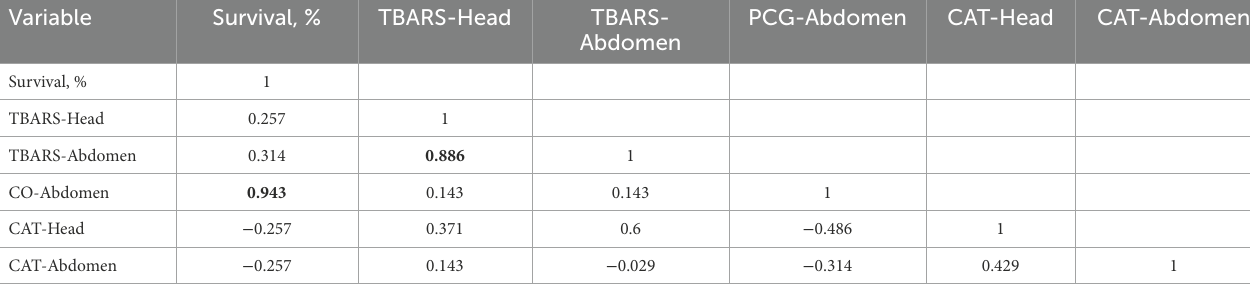
TABLE 1 Spearman rank order correlations among survival of bees and biomarkers of oxidative stress.